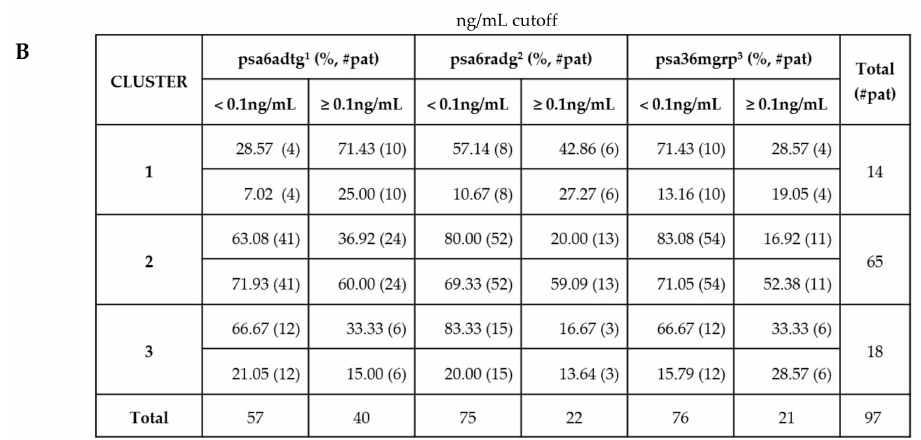
Figure 7. Centroid cluster analysis of 3D nuclear profiling of CTCs from 97 patients with high-risk prostate cancer ( A ). The combination of telomere parameters (Materials and Methods) allows the stratification of patients into clusters. Each cluster possesses a di ff erent level of genomic instability and di ff erent risk of future prostate mortality, based on their PSA end values after 6 months of ADT 6 months of RT, and 36 months after initial treatment ( B ). Patients in cluster 3 (green) had the highest percentage of patients with PSA ≥ 0.1ng / mL after treatment, while those in cluster 2 (red) and cluster 1 (blue) had an intermediate- to low percentage of patients with PSA ≥ 0.1ng / mL after